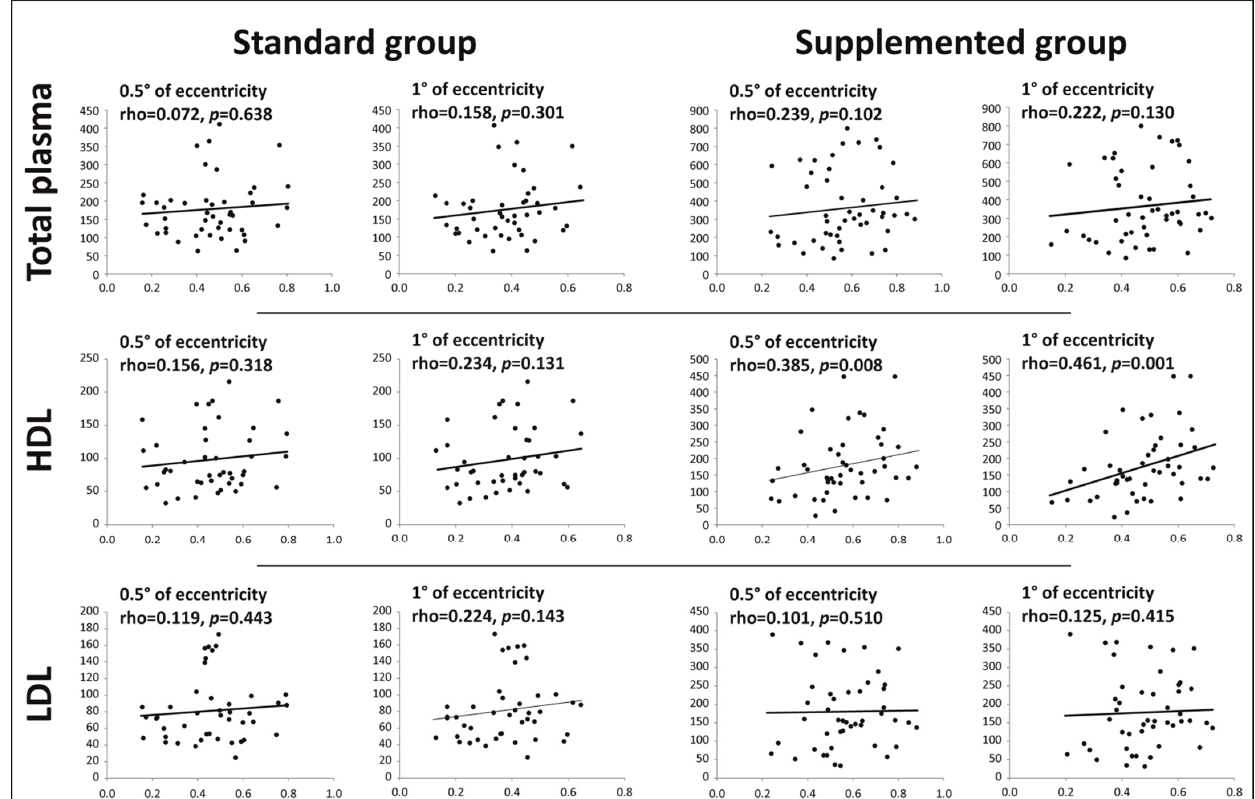
Figure 2. Correlation between total plasma, HDL, and LDL concentrations of lutein and MPOD at 0.5° and 1° eccentricities. Lutein concentrations are expressed as ng/mL of plasma in total plasma and as ng/mg of proteins in HDL and LDL fractions ( y axis). MPOD is expressed as density units ( x axis). n = 48 in standard group, n = 49 in enriched group. Correlations were assessed by using Spearman’s test.